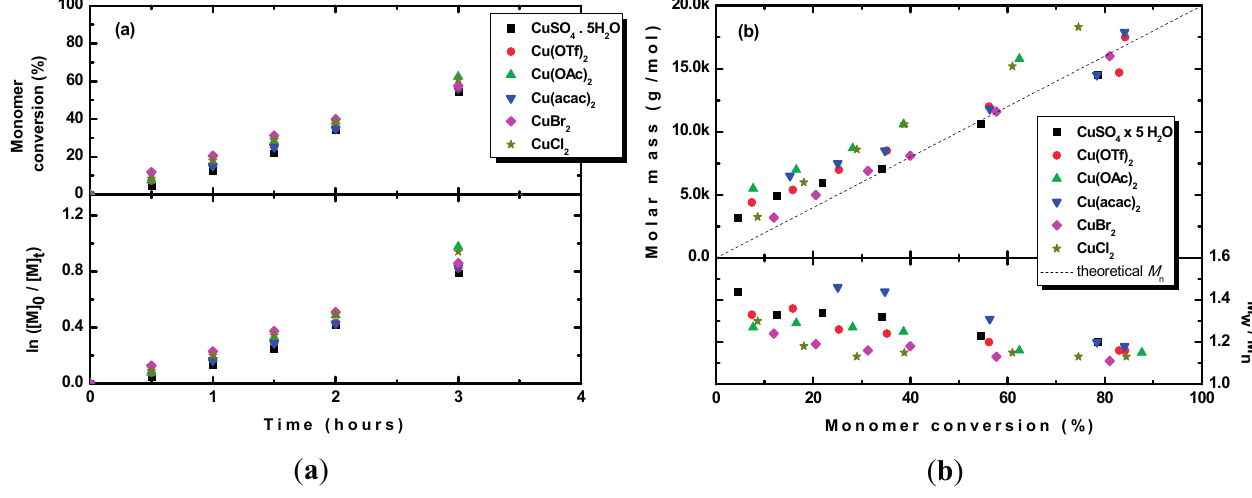
Scheme 1. Schematic mechanism of photochemical reduction of various copper(II) compounds and subsequent formation of CuBr/CuBr 2 equilibrium ensuring good control in